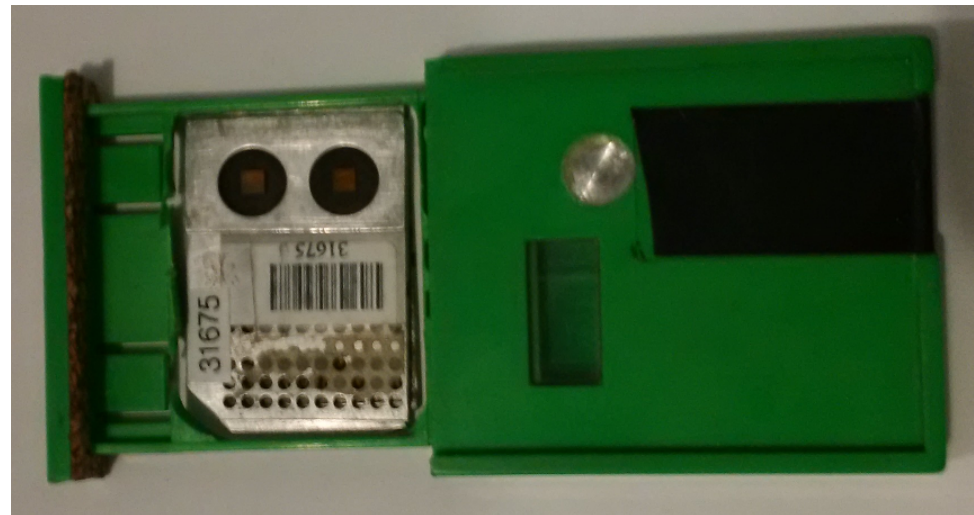
Figure 3. TLD housing (badge) with “thin” (TLD-700) and “thick” (TLD-100) chips were used in this study. To improve statistics, two aluminum plaques with TLD chips were used, one on top of the other. Note that two aluminum plaques, “front” and “rear”, are located in the badge on top of each